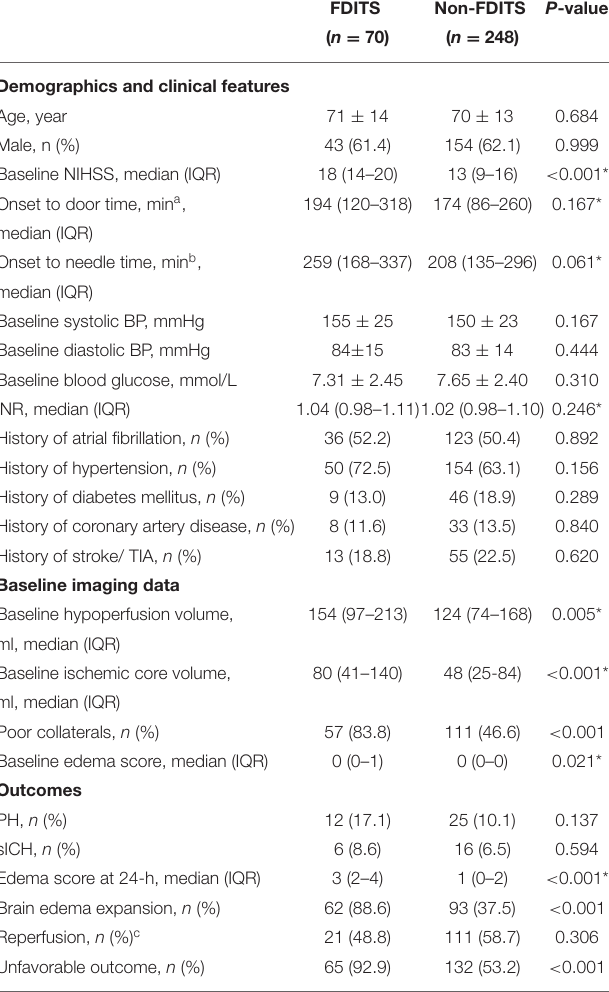
TABLE 1 | Baseline characteristics and outcomes dichotomized by the presence of FDITS.